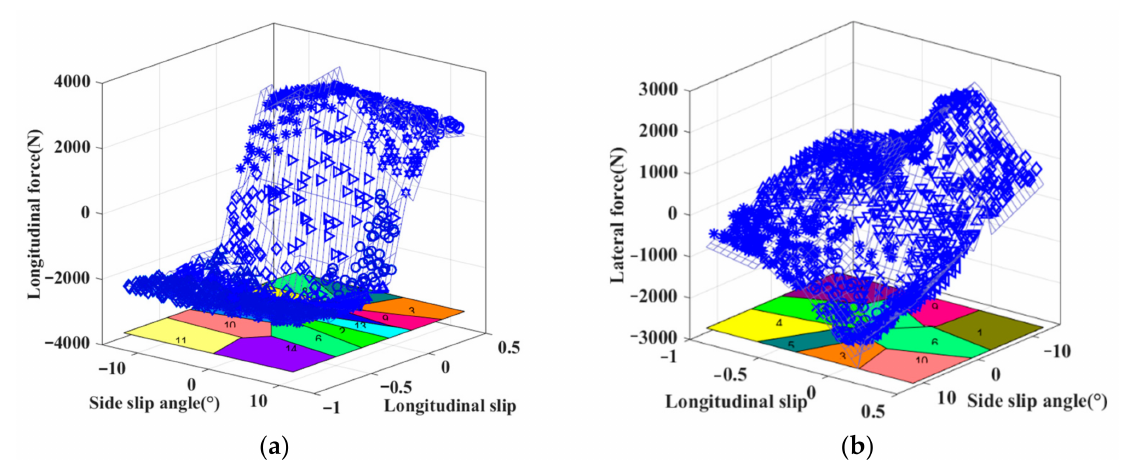
Figure 4. ( a ) Simulation result of the identified PWA model for approximating the nonlinear rela- tionship between the tire longitudinal force and its influence factors; ( b ) Simulation result of the identified PWA model for approximating the nonlinear relationship between the tire lateral force and its influence